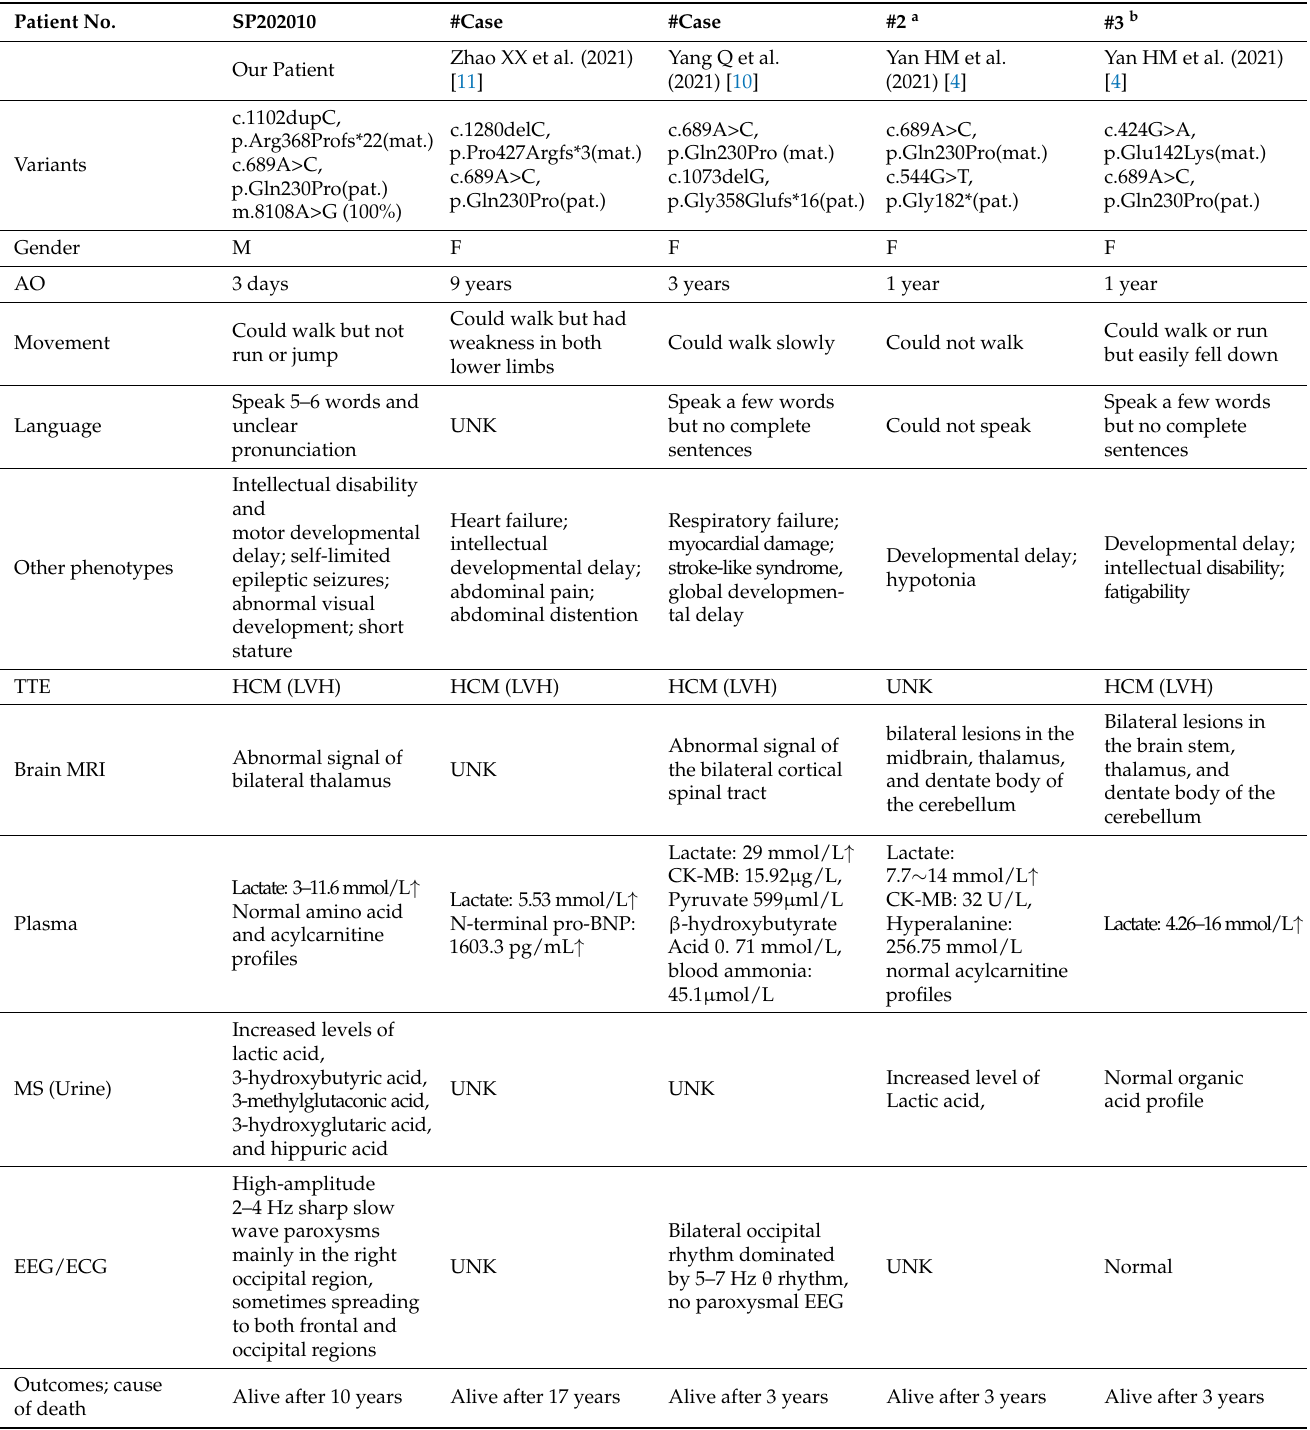
Table 2. Comparison of clinical and genetic characteristics of patients carrying GTPBP3 variant